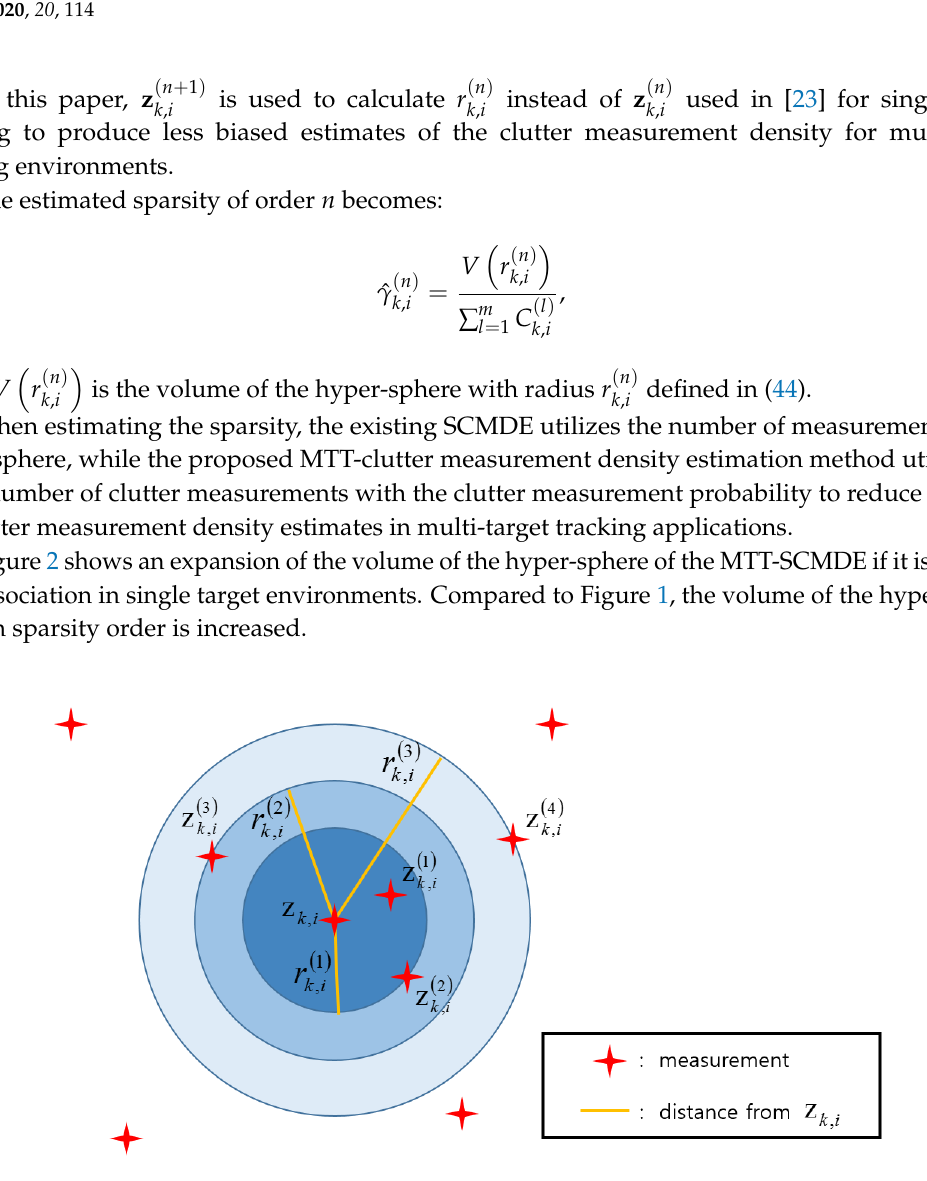
Figure 2. Hyper-spheres for the multi-target tracking (MTT)-SCMDE used for single target tracking in a 2D